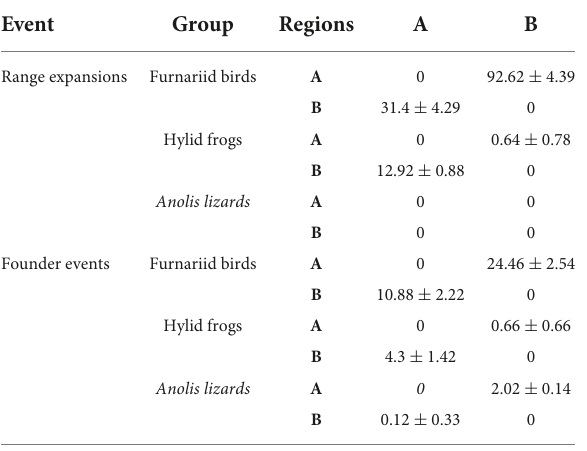
TABLE 4 Frequency of dispersal events inferred using biogeographical stochastic mapping (BSM) for the three taxonomic groups examined in this study (Furnariides birds, hylid frogs, and Anolis lizards) across two regions. Event